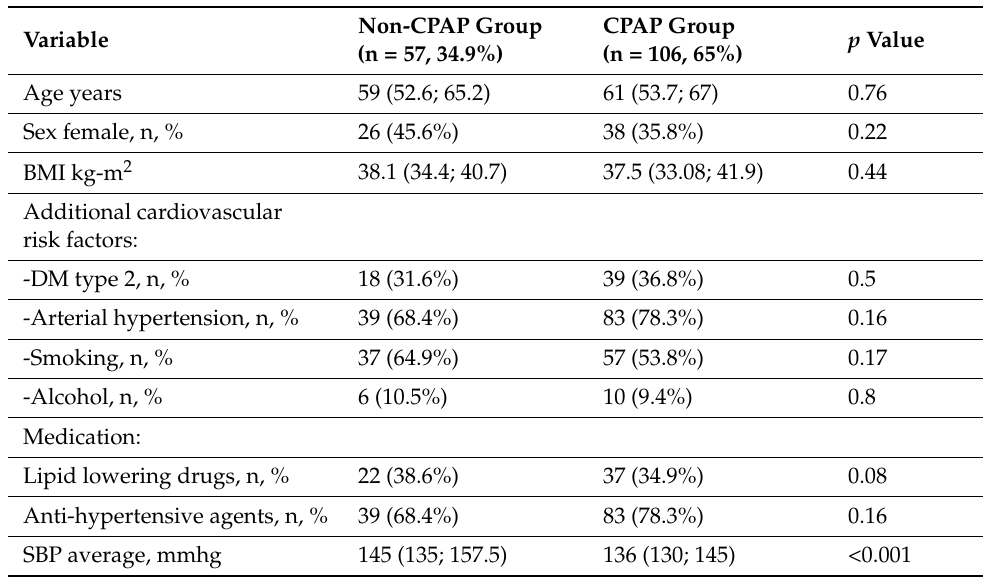
Table 1. Baseline Characteristics of all Randomized